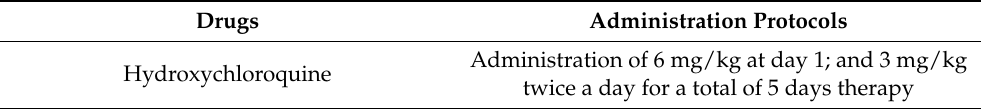
Table 6. COVID-19 hydroxychloroquine dosage